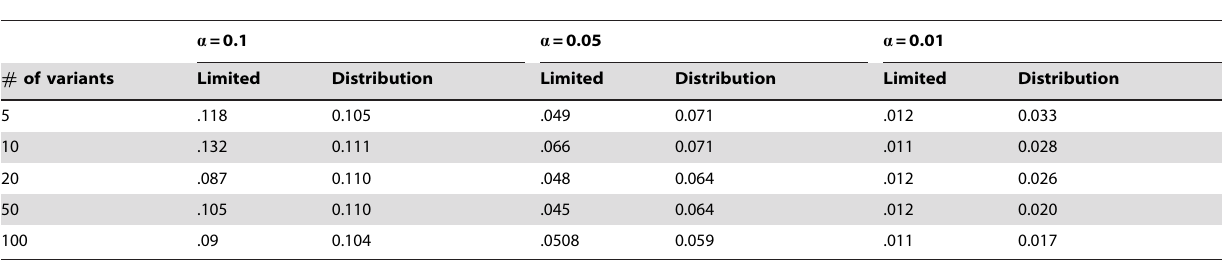
Table 2. Null simulation results for small sample